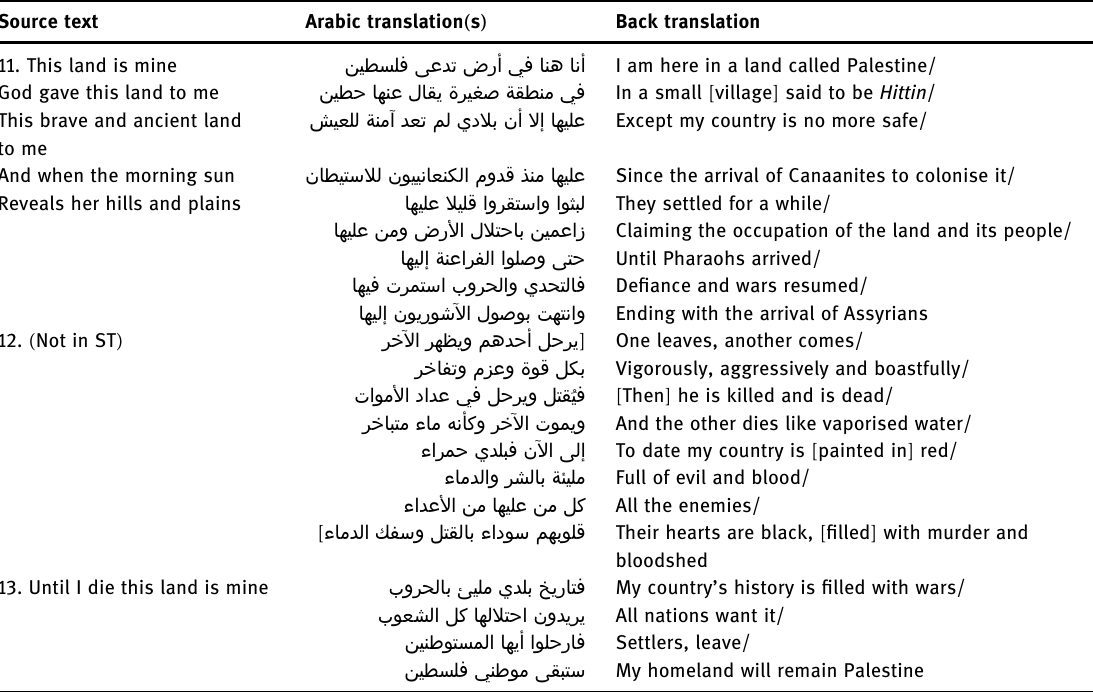
Table 4: Examples of visual impact on the decision - making process Source